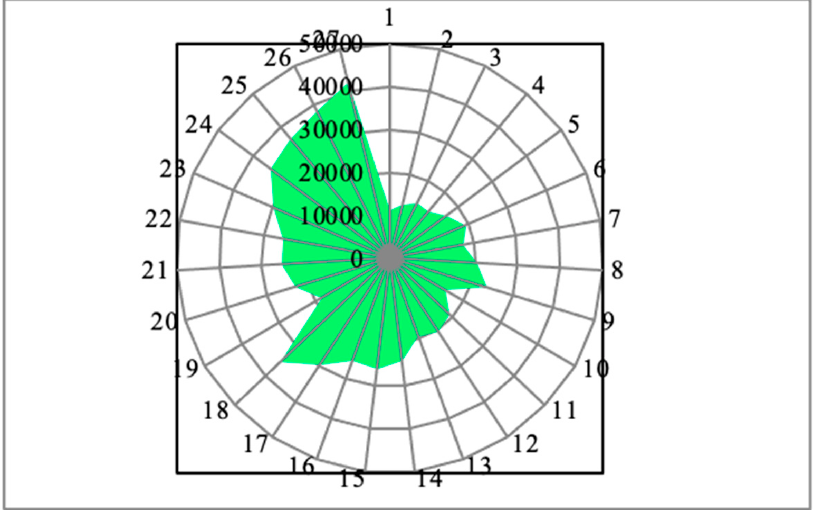
Figure 28. Radar diagram of the response material removal rate (mm 3 /min) for each specimen.